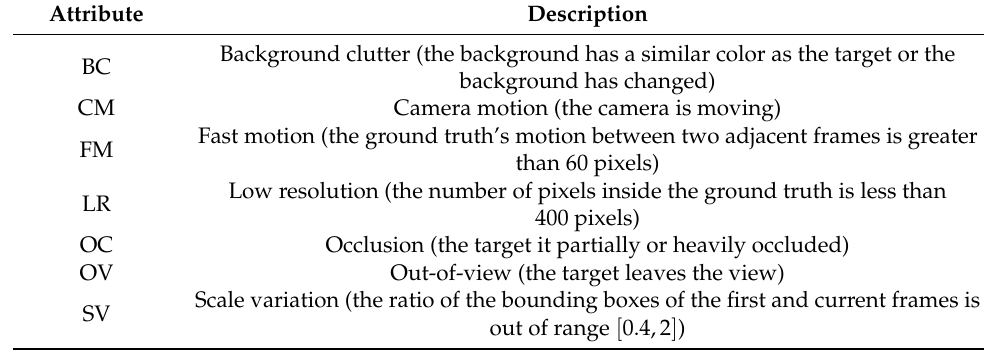
Table 1. A tt ribute annotation in dataset.